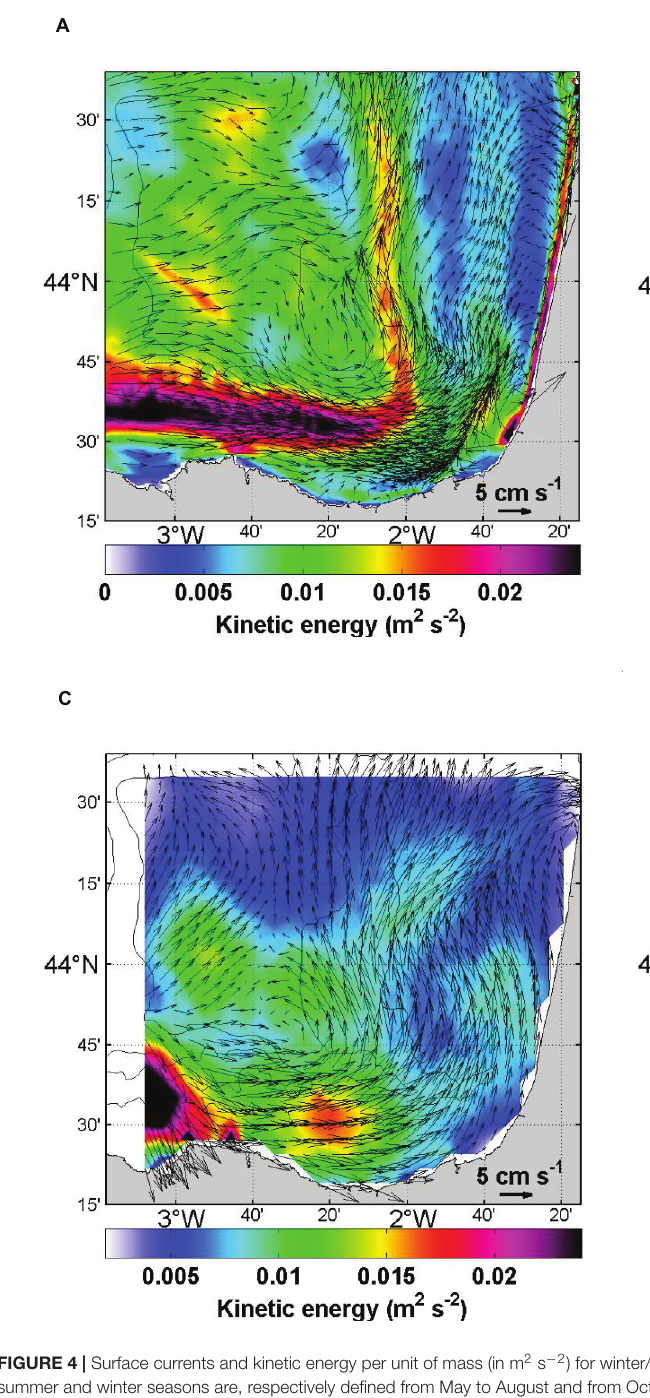
et al. (2014) is indeed efficient, but that a residual ageostrophic signal is still